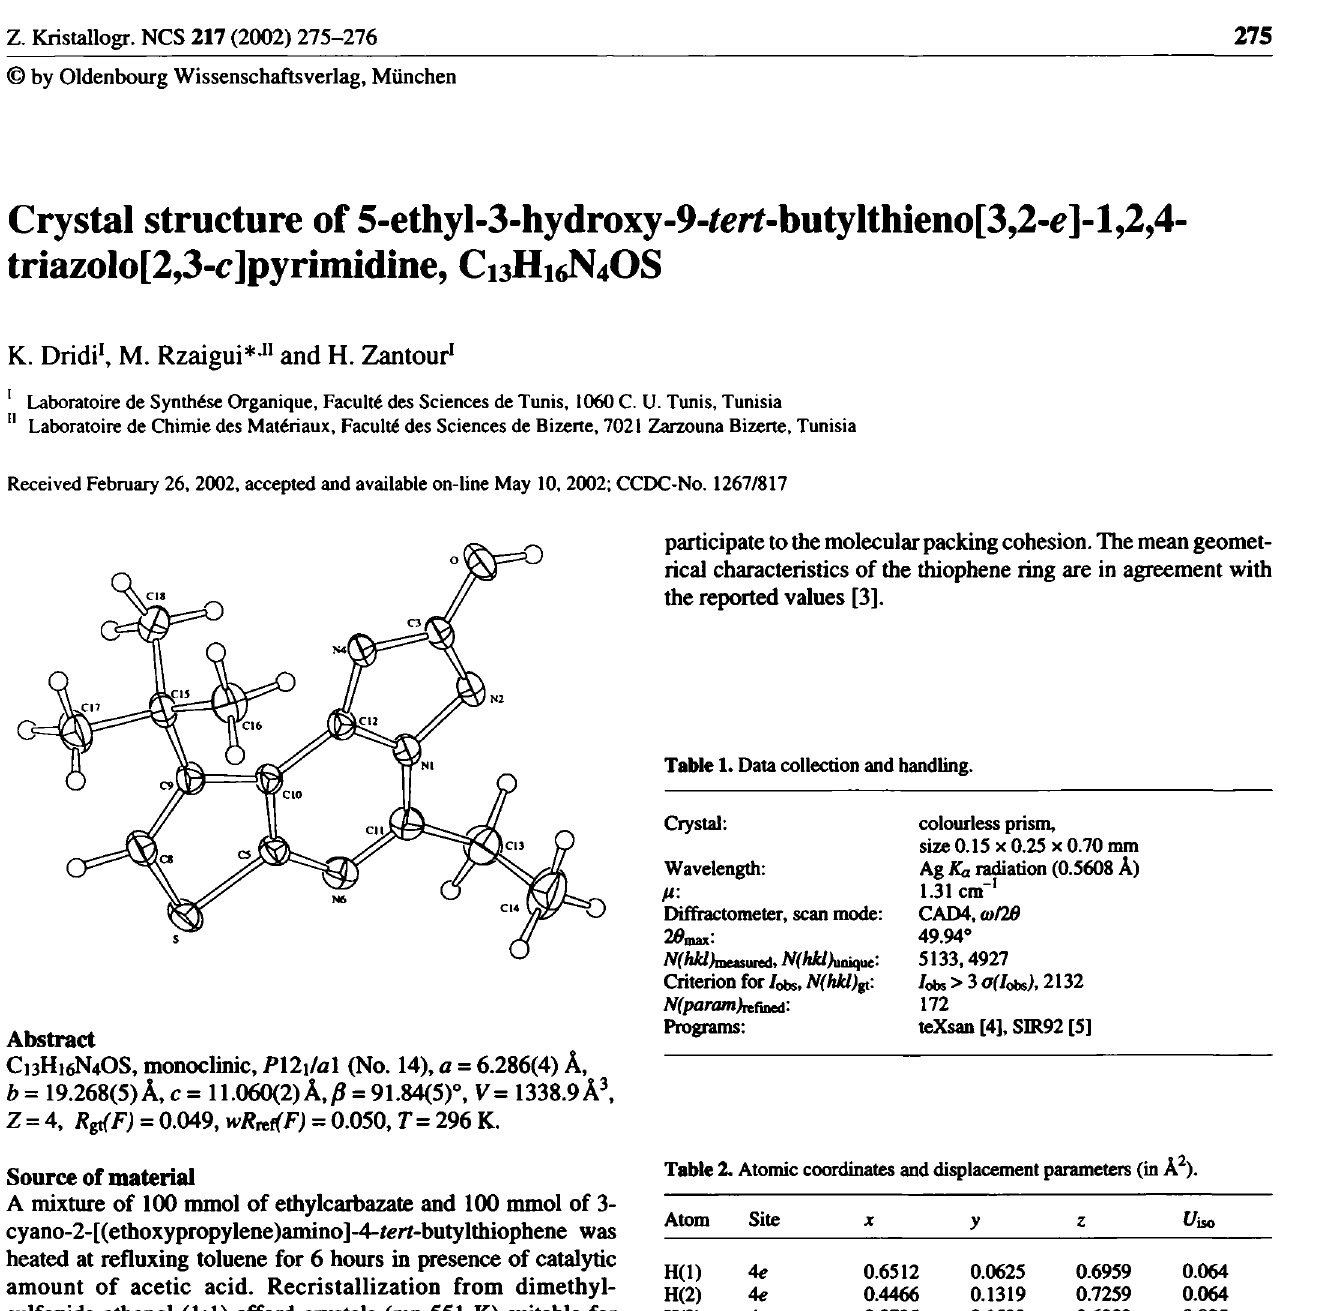
Table 2. Atomic coordinates and displacement parameters (in À 2